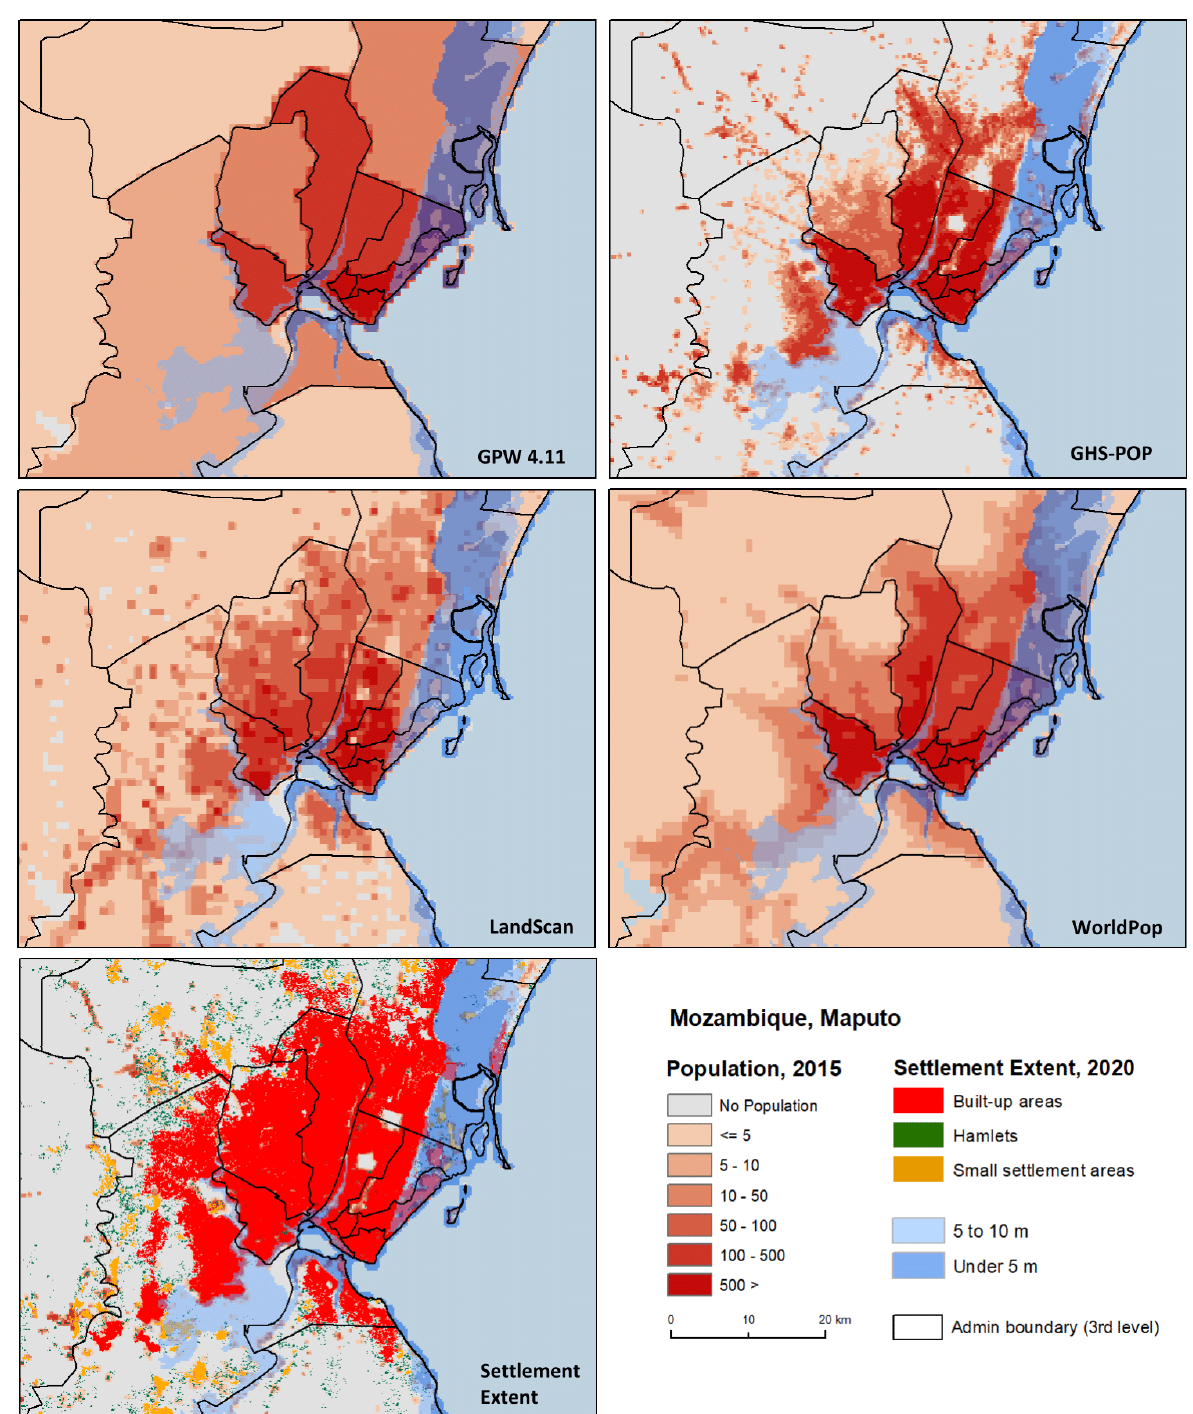
Figure B9. Comparison of population distributions by population data sources shown with administrative boundaries and GRID3 building- footprint-derived settlement extent data, Maputo and surrounding